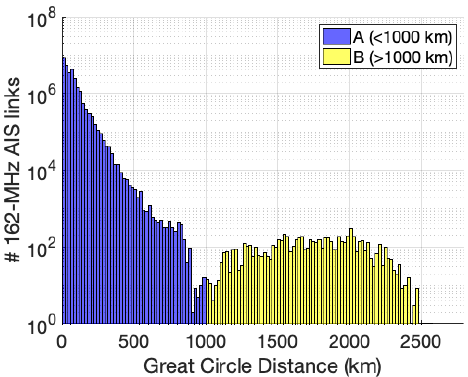
Figure 1. Histogram of AIS link great-circle distances from the USCG network in the eastern USA covering 13–15 July 2021. Pop- ulation A ( < 1000km) might be explained by line-of-sight propa- gation, surface waves, and tropospheric ducting, while Population B ( > 1000km) is not predicted by those mechanisms. The longest re- ported link in our dataset covered a great-circle distance of 5453km (not